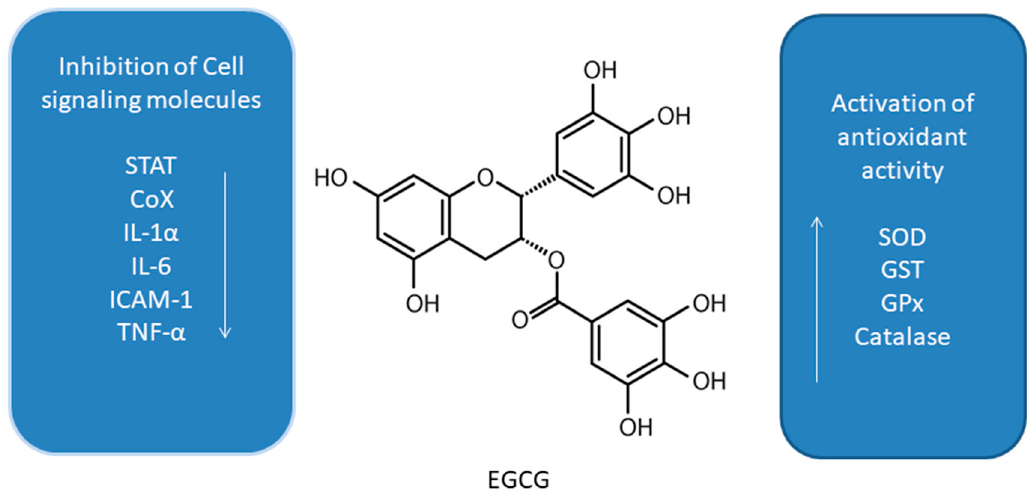
Figure 1. Effect of epigallocatechin-3-gallate (EGCG) on interplay between antioxidant activity and inhibition of cell signaling molecules